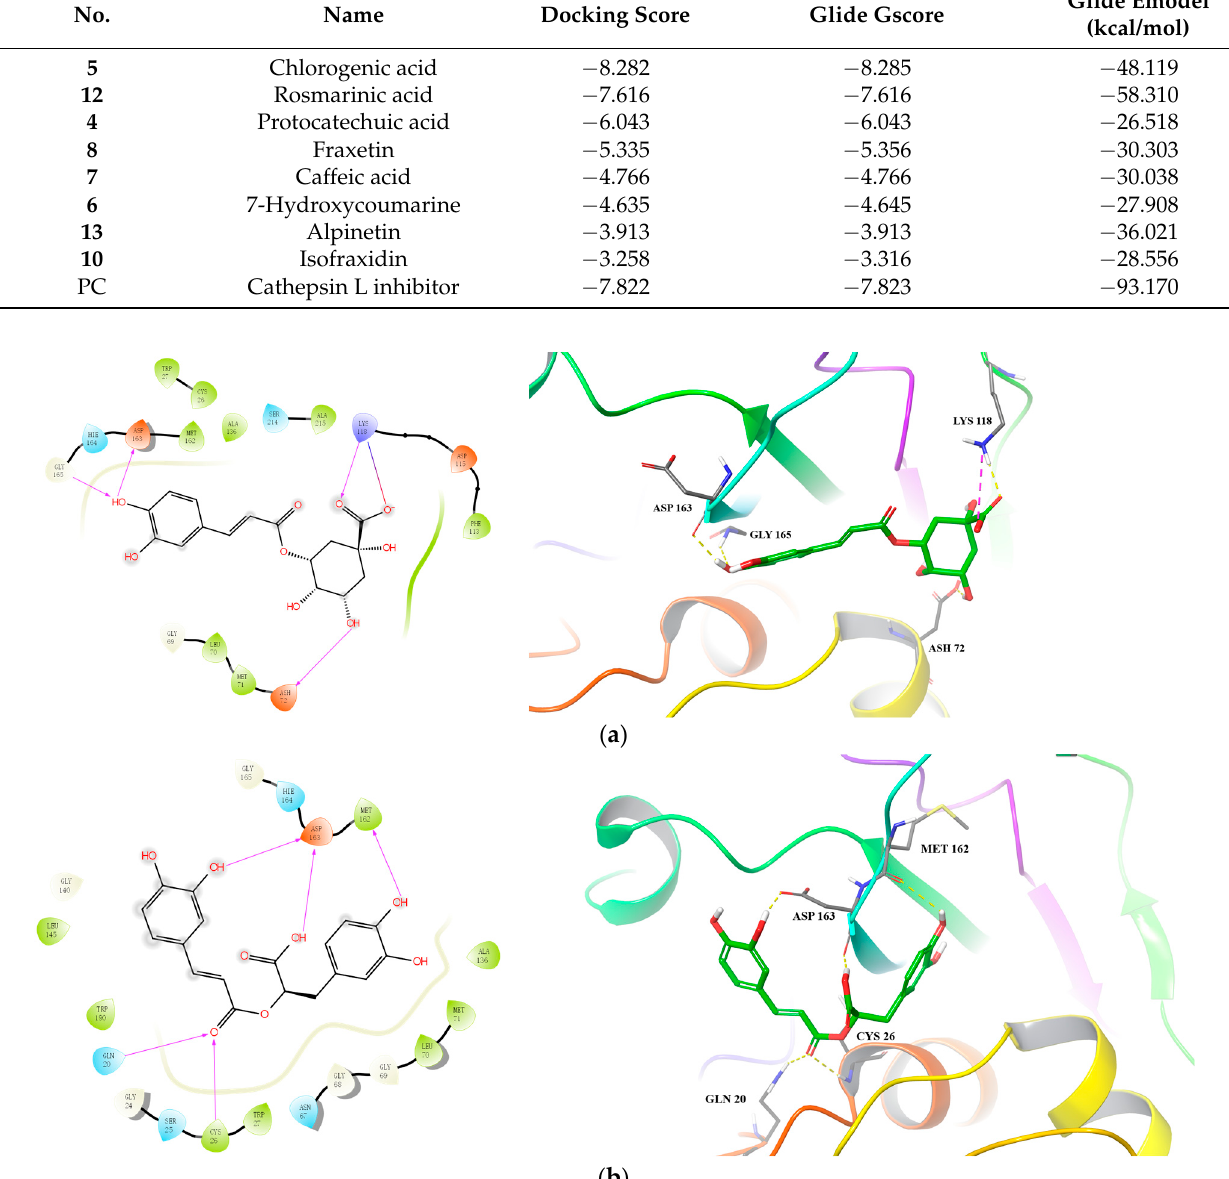
Figure 3. Predicted binding of chlorogenic acid ( a ) and rosmarinic acid ( b ) to CatL PR. Table 5. Docking main bioactive compounds from Sarcandra glabra extracts against CatL PR. (PDB ID: 3OF9).